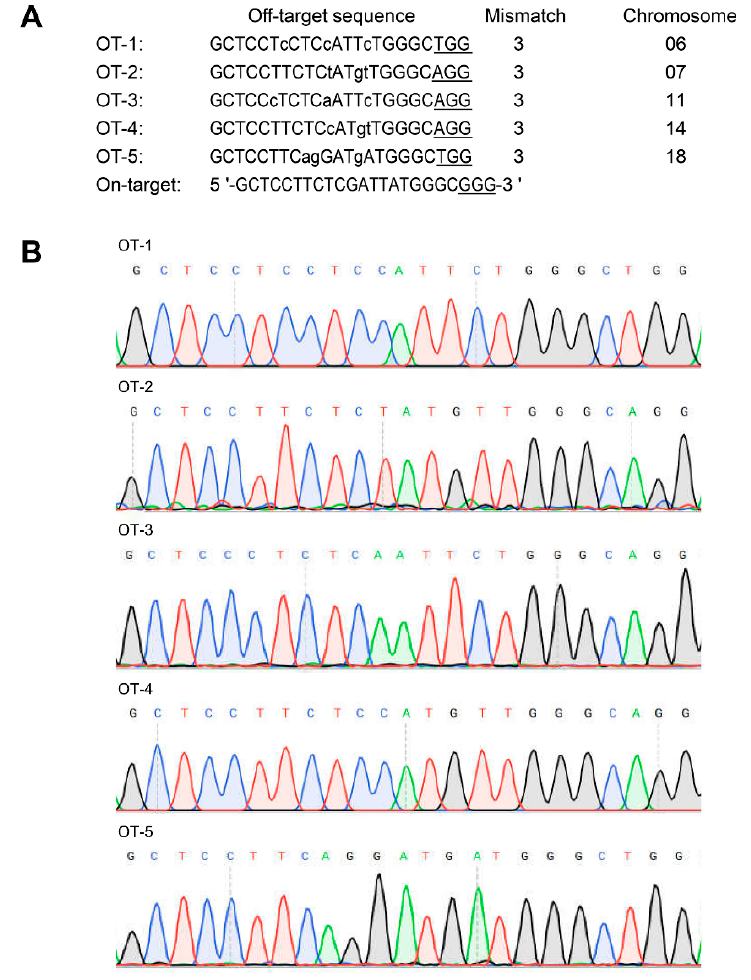
Figure 3. Off-target analysis. ( A ) Predicted off-target sites. Lower case letters represent mismatched Figure 3. O ff -target analysis. ( A ) Predicted o ff -target sites. Lower case letters represent mismatched bases, while underlined letters represent the 3 (cid:48) PAM of the target sequence. ( B ) Sanger sequencing bases, while underlined letters represent the 3 ′ PAM of the target sequence. ( B ) Sanger sequencing results of the PCR products of potential o ff -target results of the PCR products of potential off-target sites.